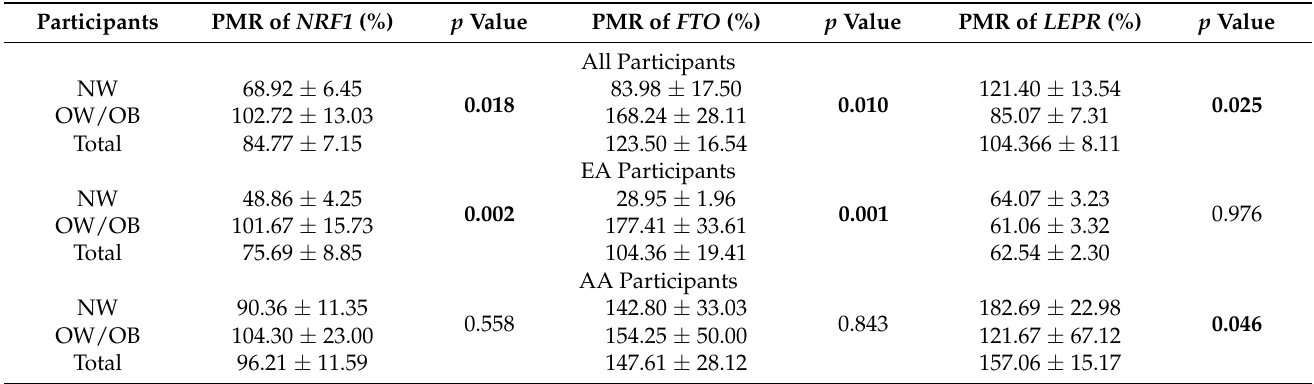
Table 4. Race-Specific Descriptive Analysis of PMR of NRF1 , FTO and LEPR .